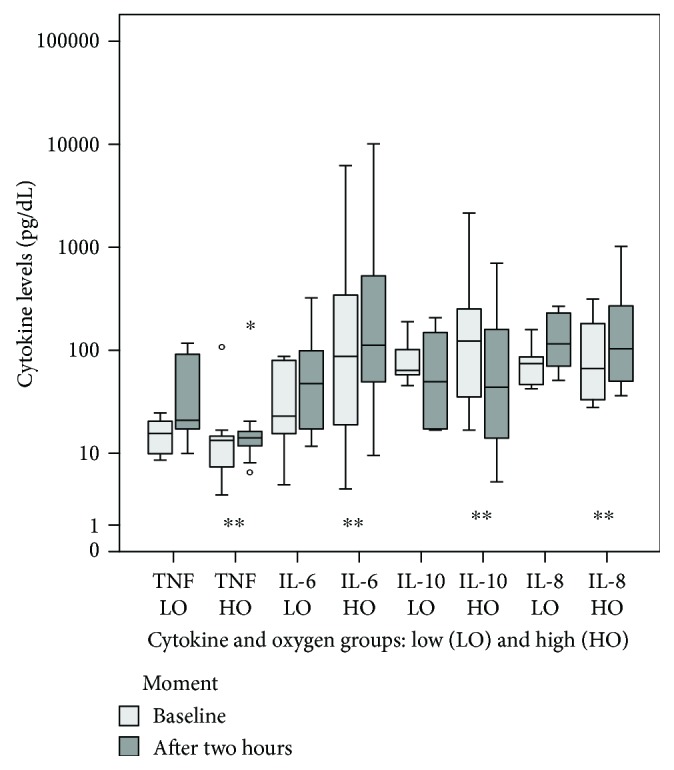
Cytokine levels immediately after the onset of MV and after 2 hours—Wilcoxon's test; ∗outlier, ∗∗p < 0.05.